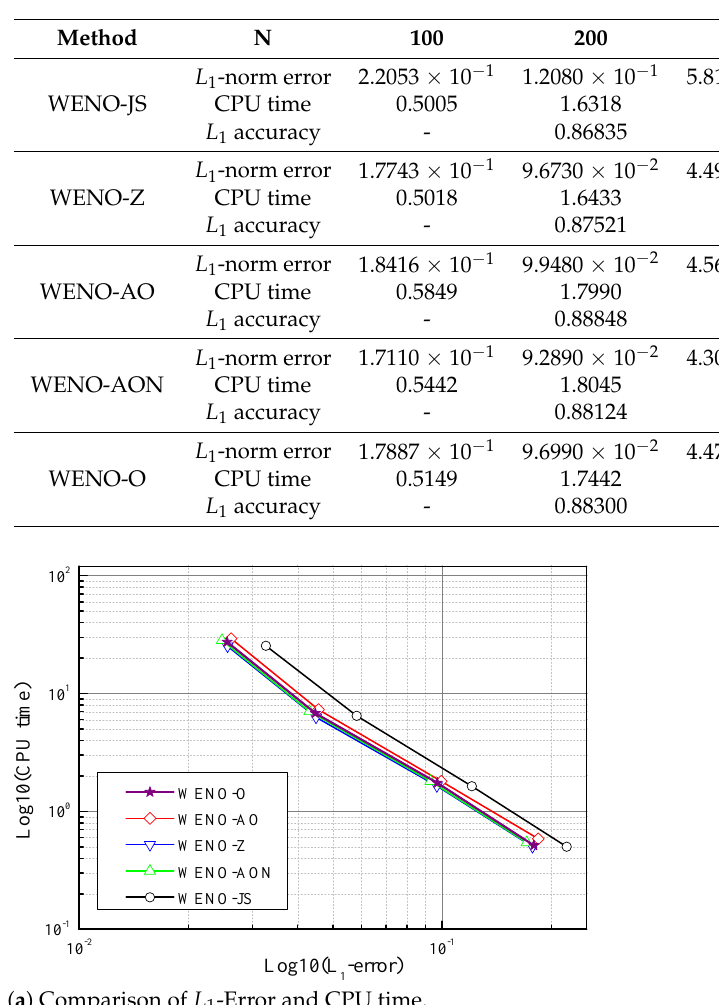
Table 6. The accuracy of Lax’s test of Example 4 (Section 6.2.1) in one dimension with WENO-AO, WENO-AON, WENO-JS, WENO-Z and WENO-O schemes.